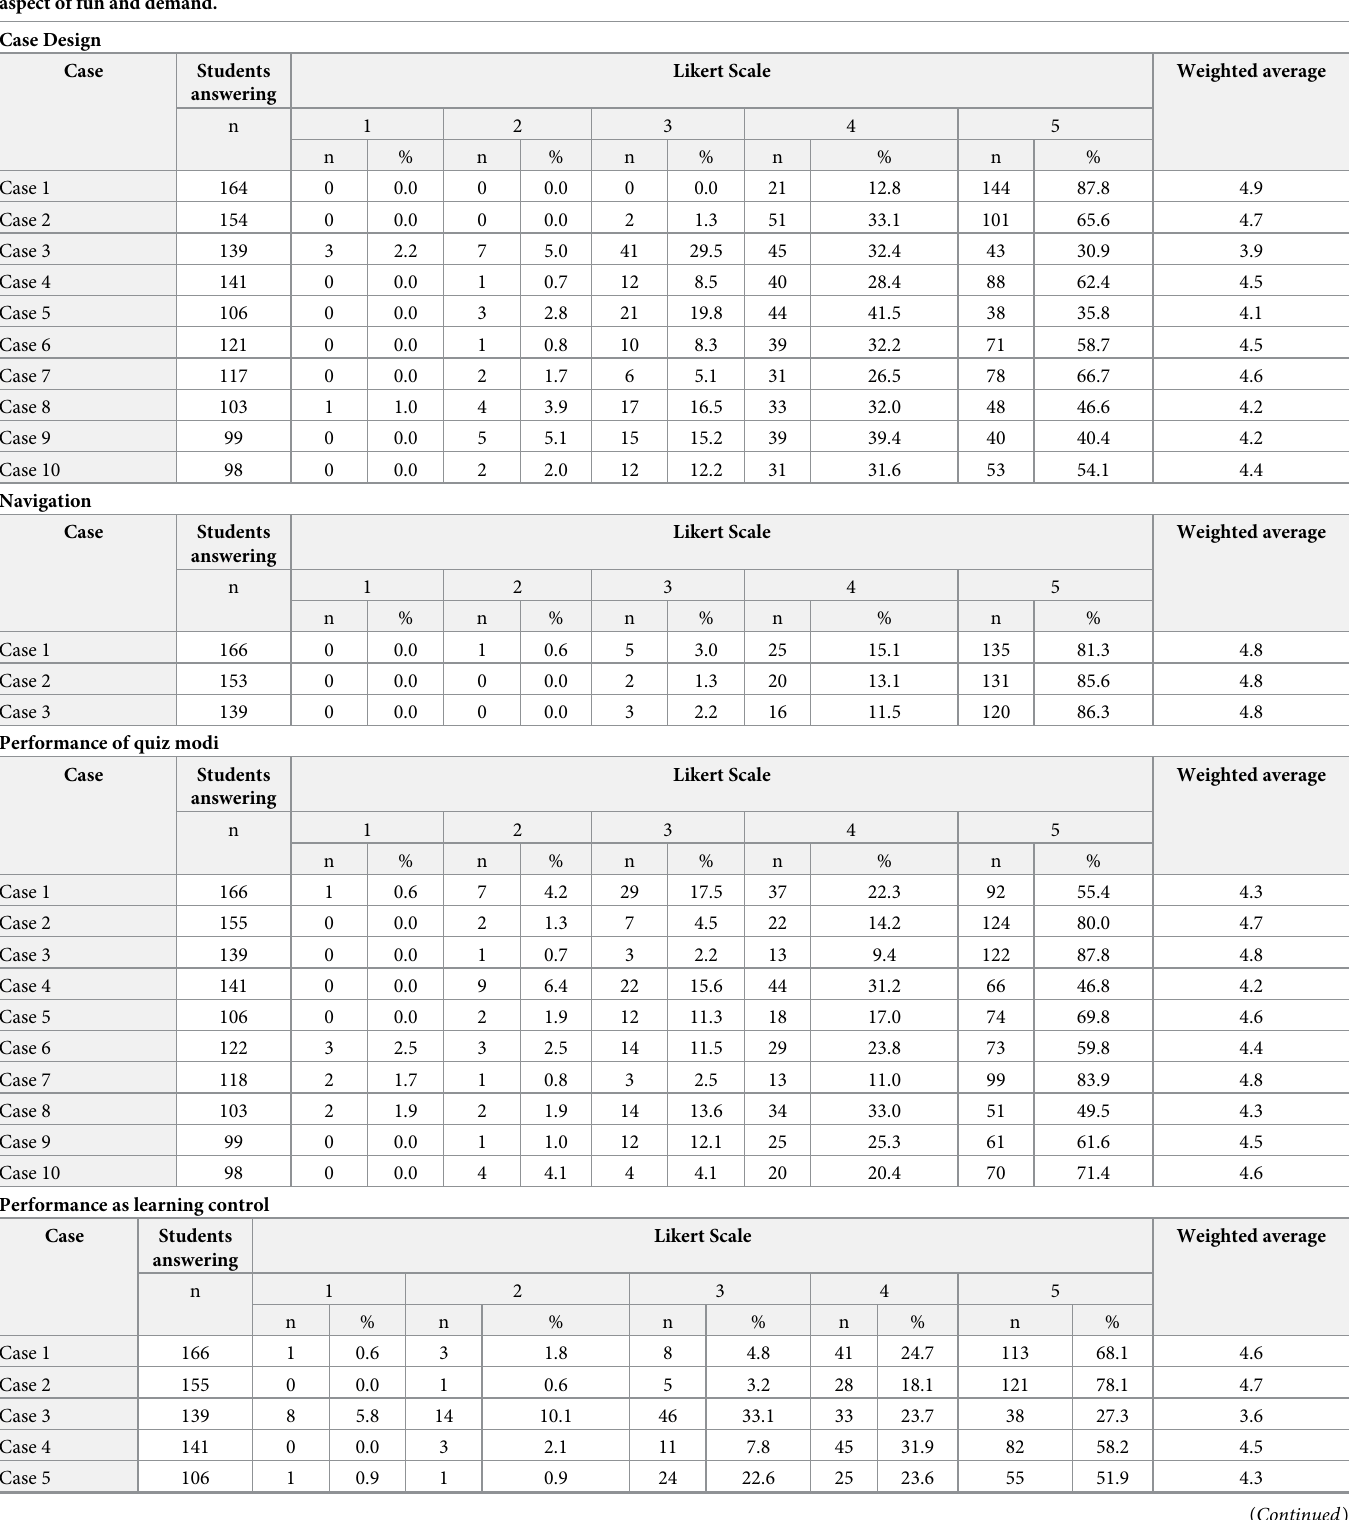
Table 1. Case-to-case evaluation by students for structure, navigation, quiz functions, performance as learning control, helpfulness of senior physician’s comments, aspect of fun and demand. Case